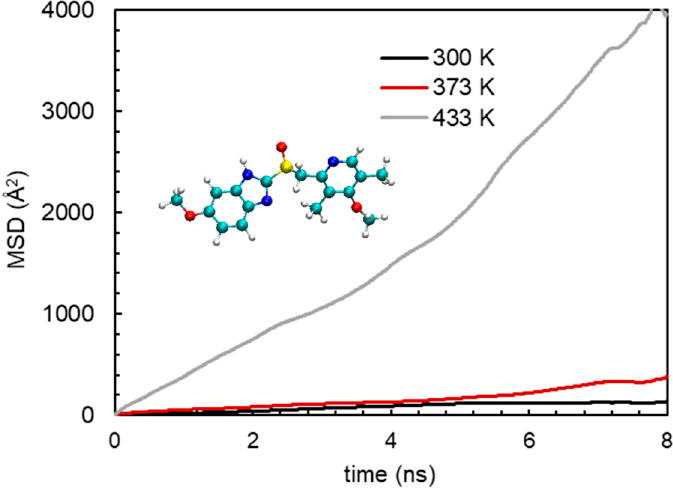
Figure 13. Mean-squared deviations (MSDs) of DMF in HPMC(AS) at temperatures of 300, 373, and 433 K.